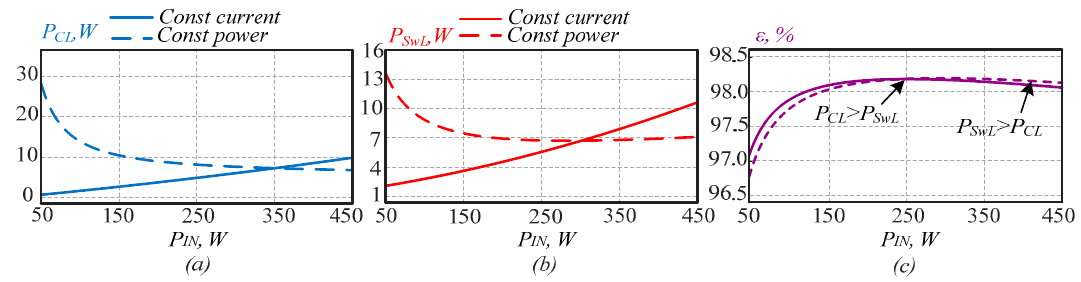
Figure 6. Power losses estimation of the inverter: conduction losses of semiconductor switches ( a ), switching losses of transistors ( b ), efficiency estimation ( c ).